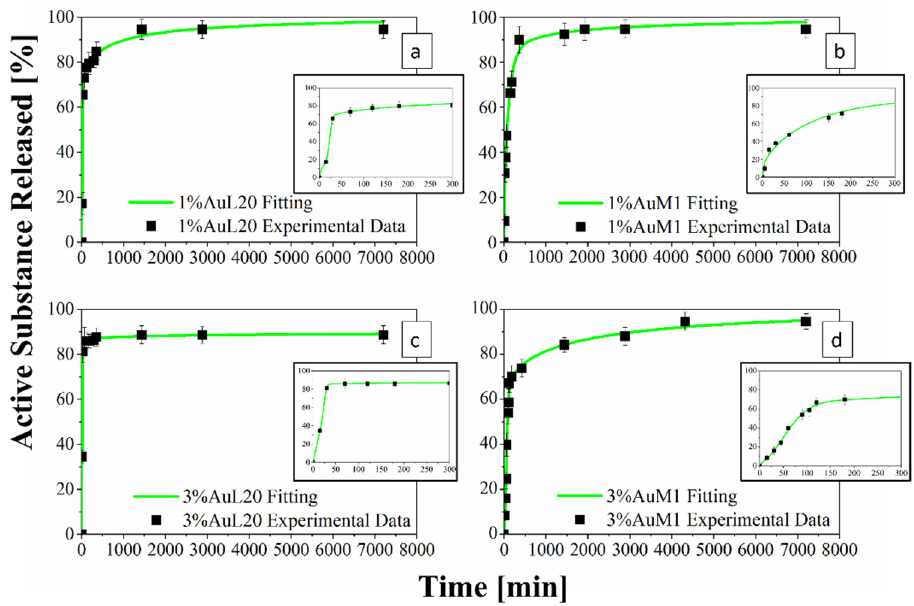
Table 6. Modified Weibull Model parameters.